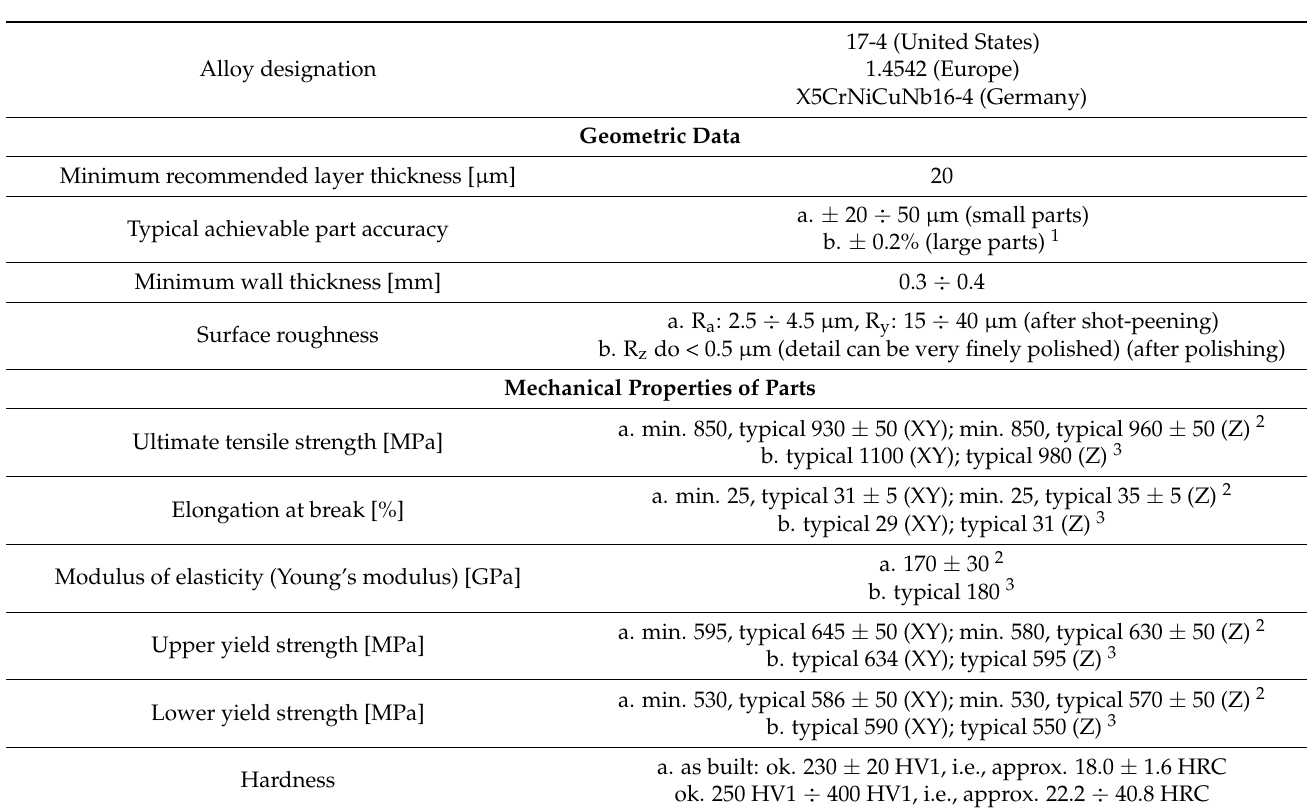
Table 3. Selected material data of stainless steel 17-4